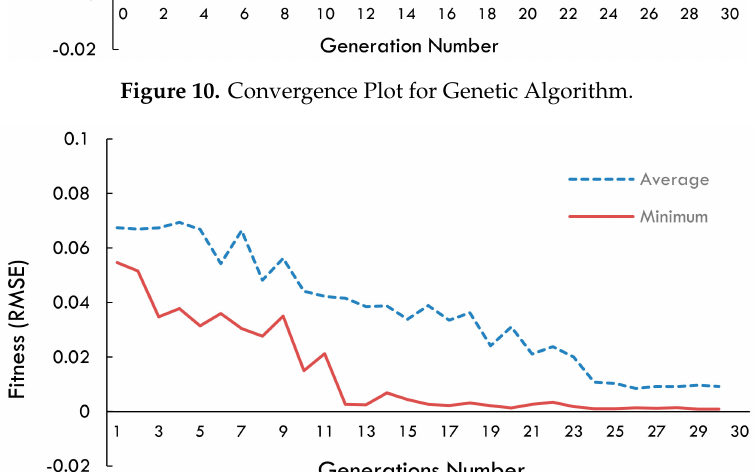
Figure 11. Convergence plot for the PSO algorithm.